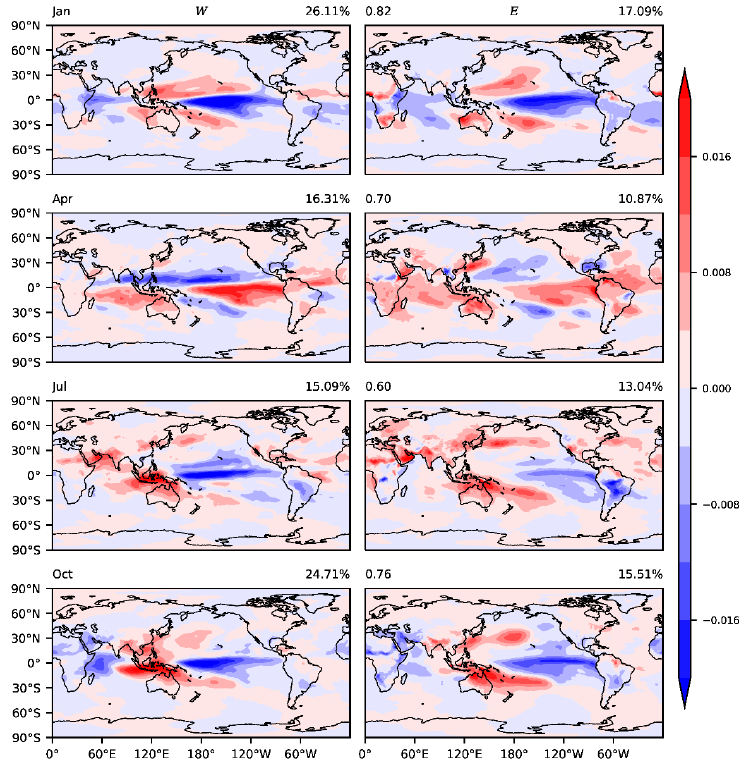
Figure 9. The first EOF (EOF1) modes of PW ( left ) and SVP ( right ) calculated with ERA5. The rows from top to bottom correspond to January, April, July, and October, respectively. The percentages at the top-right of subgraphs are fractional mode variances corresponding to PW and SVP. The numbers at the upper-left corners of graphs in the right column are spatial correlation coefficients of the first modes of PW and SVP.